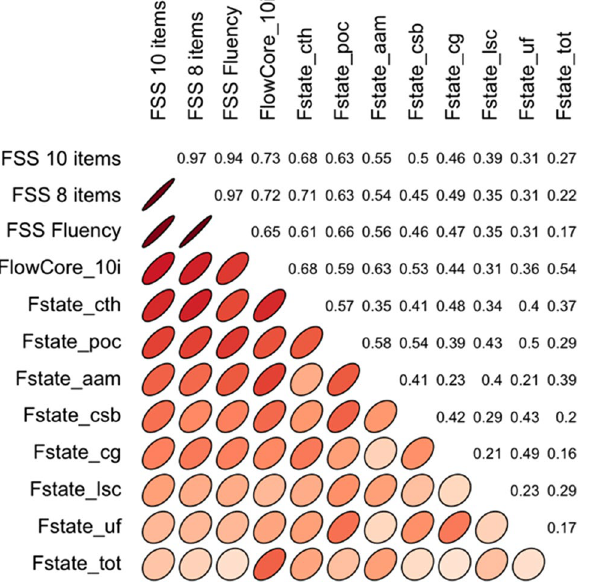
Figure 4. Sensitivity analysis (correlation matrix and visualization) for different versions of FSS. FSS = Flow Short Scale; FSS Fluency = 6 item FSS comprising only Fluency subscale; Fstate = Flow State Scale; cth = Concentration on task at hand; poc = Paradox of control; aam = Action-awareness merging; csb = Challenge-skill balance; cg = Clear goals; lsc = Loss of self-consciousness; uf = Unambiguous feedback; tot = Transformation of time. The ellipses and their colours depict the strength of the correlation (thinner and darker ellipse = stronger